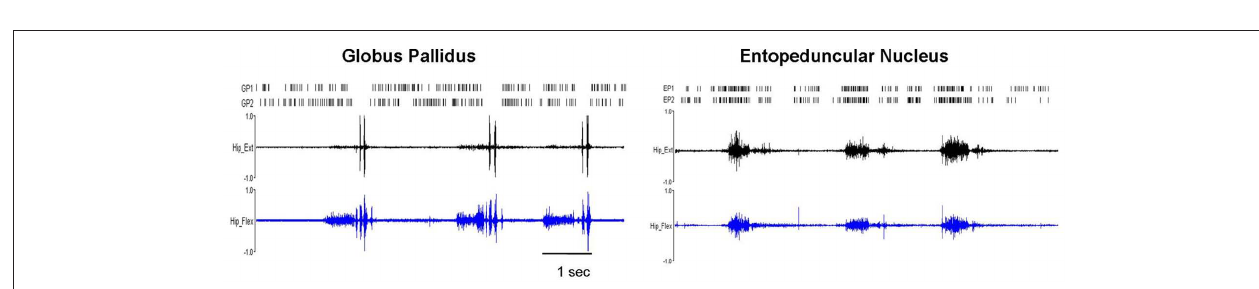
Figure 5 | Pathologically synchronized signaling in severely dystonic animals. In more severely dystonic rats ( n = 2), exclusively, simultaneously recorded units showed abnormally synchronized movement related pauses in GP ( n = 5 pairs, p < 0.001) and bursts in EP ( n = 4 pairs, p < 0.001). In distinction, synchronized discharges were never seen in the